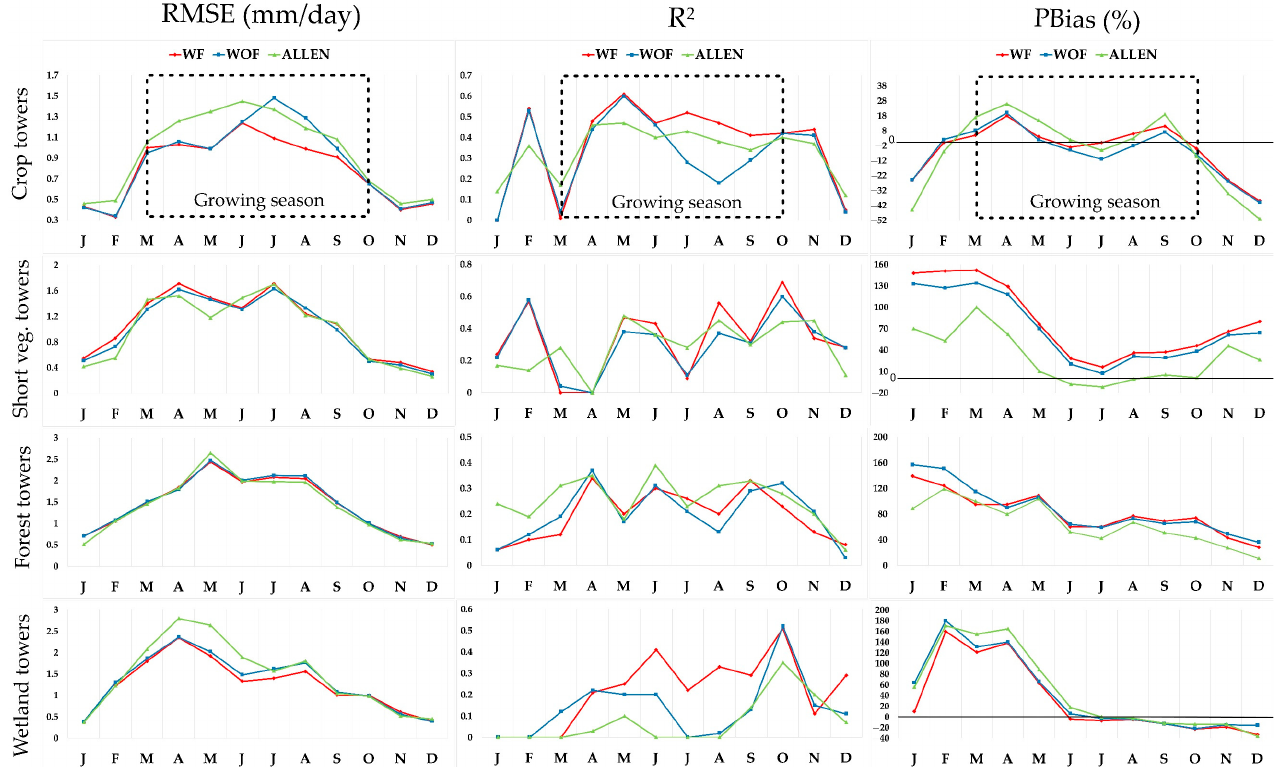
Figure 6. Monthly ET evaluation of WF, WOF and Allen models based on land cover type.